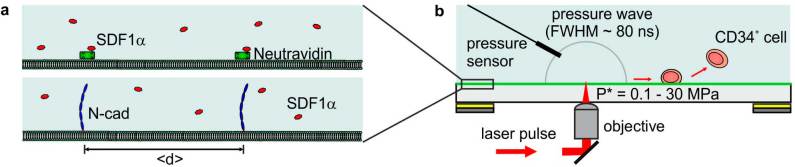
Experimental set-up.Schematic illustrations of (a) the defined surrogate MSC model based on supported membranes and (b) a novel assay to quantify the cell detachment pressure using a laser-induced pressure wave.